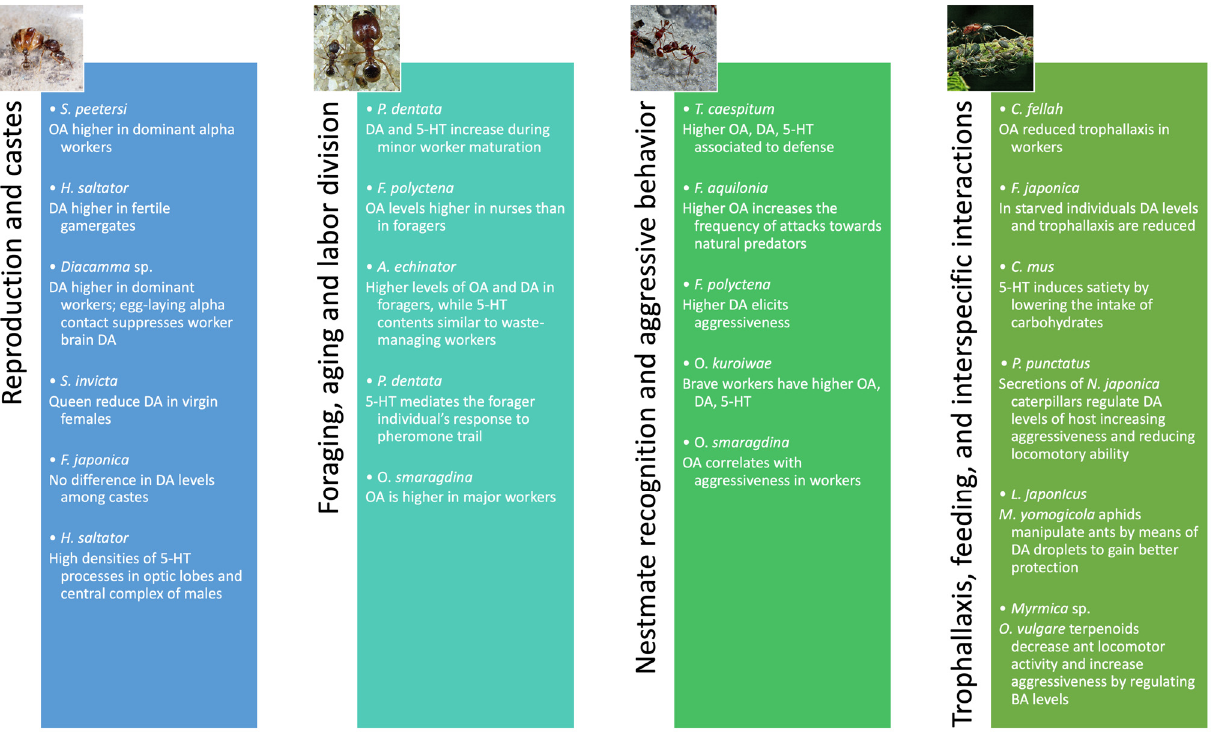
Figure 6. Main functions of BAs in ants. The examples listed in the figure are reported in the following references [24,50–54,57,60,62,66–68,75,82–87,89–92].